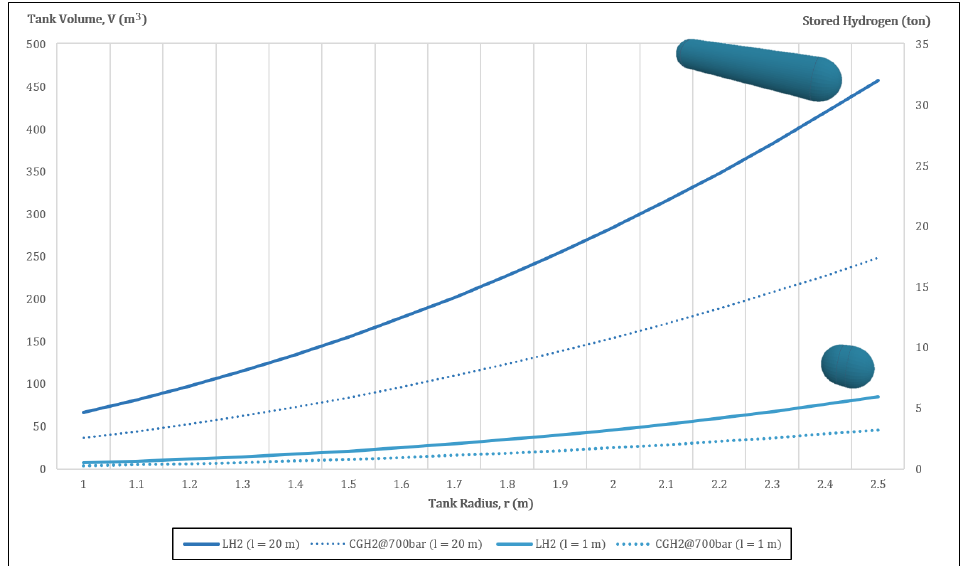
Figure 3. Relation between radius, volume, and stored mass of a typical hydrogen capsule-shaped tank. Values obtained from Equation (1); hydrogen density from [20]. Note: Dimensions shown here are of the interior vessel. Nowadays’ cryogenic trailers may have these dimensions for the exterior tank, thus having much smaller interior capsules than the ones shown in this graph. For example, when Kawasaki announced its Hydrogen Road vision for the future [13], concept designs of liquefied hydrogen containers for land transportation carried about 5000 kg of liquid